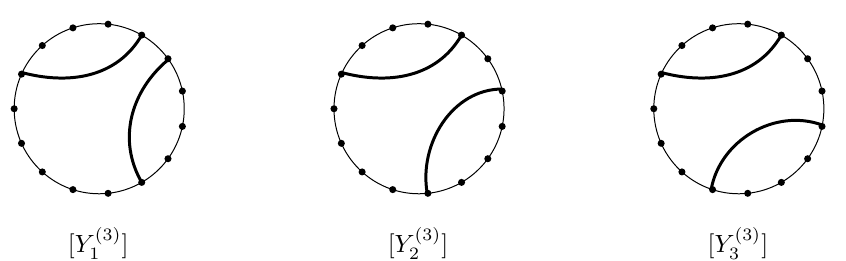
Figure 4. The 3 cyclically distinct weak separation graphs for n = 15 ; k = 3. Each corresponds to the indicated cyclic class [ Y (3) (cid:11) ] of extremal Yangian invariants containing the element Y (3) (cid:11) given in (2.5) or (2.6). In each graph the interior of the circle is cut into three disjoint regions, and each disconnected component of the corresponding on-shell diagram (which we omit for the sake of clarity) would lie entirely within a single region (as in (cid:12)gure 1).